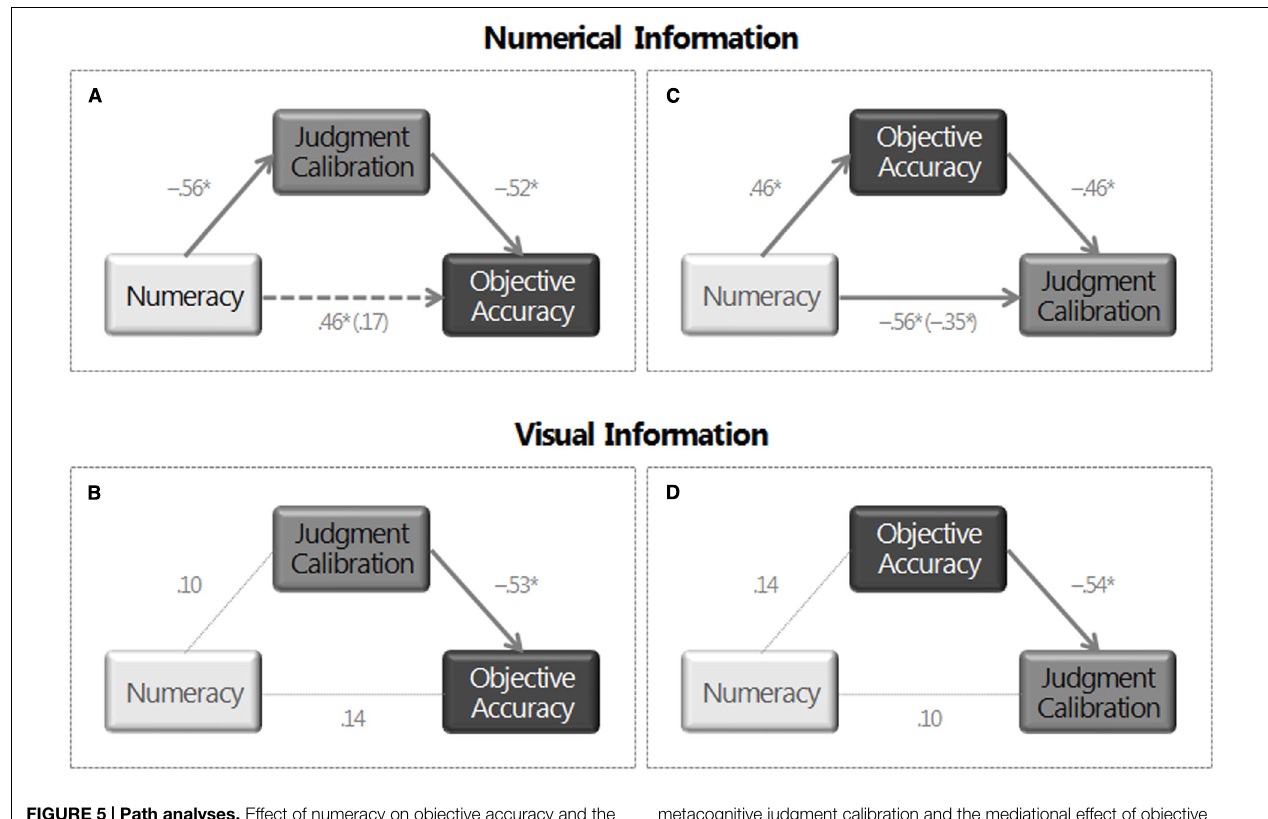
FIGURE 5 | Path analyses. Effect of numeracy on objective accuracy and the mediational effect of metacognitive judgment calibration when (A) patients received information only in numbers and when (B) they received an additional visual display representing the numerical information. Effect of numeracy on